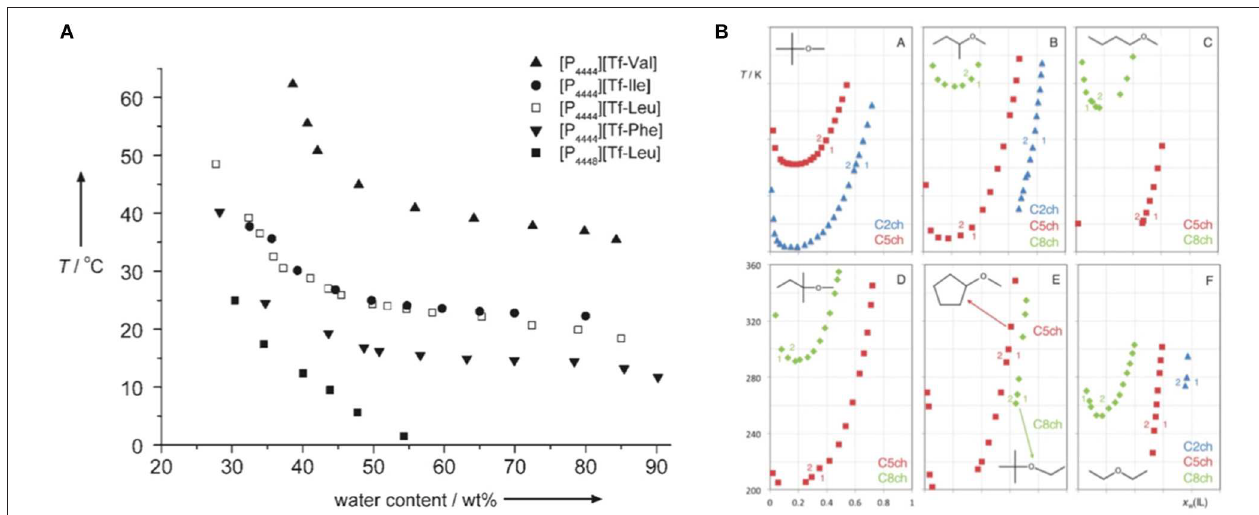
FIGURE 13 | (A) Phase-separation temperature vs. water content in mixtures of amino acid based ILs. (Reprinted from Fukumoto and Ohno, 2007 with permission from John Wiley and Sons) (B) Cloud point data for different ([N 11n2OH ][Ntf 2 ] + ether) binary mixtures. Each panel depicts a given ether molecule: A = tert-butyl methyl ether; B = sec-butyl methyl ether; C = n-butyl methyl ether; D = tert-amyl methyl ether; E = cyclopentyl methyl ether and tert-butyl ethyl ether; F = diethyl ether. Each marker/color represents a different choline cation in the ionic liquid: blue triangles = [N 1122OH ] + = C2ch; red squares = [N 1152OH ] + = C5ch; green rhombs = [N 1182OH ] + = C8ch. The arabic numerals indicate the number of phases present on each side of the boundaries defined by the cloud point data. (Reprinted from Costa et al., 2013 with permission from Royal Society of Chemistry).